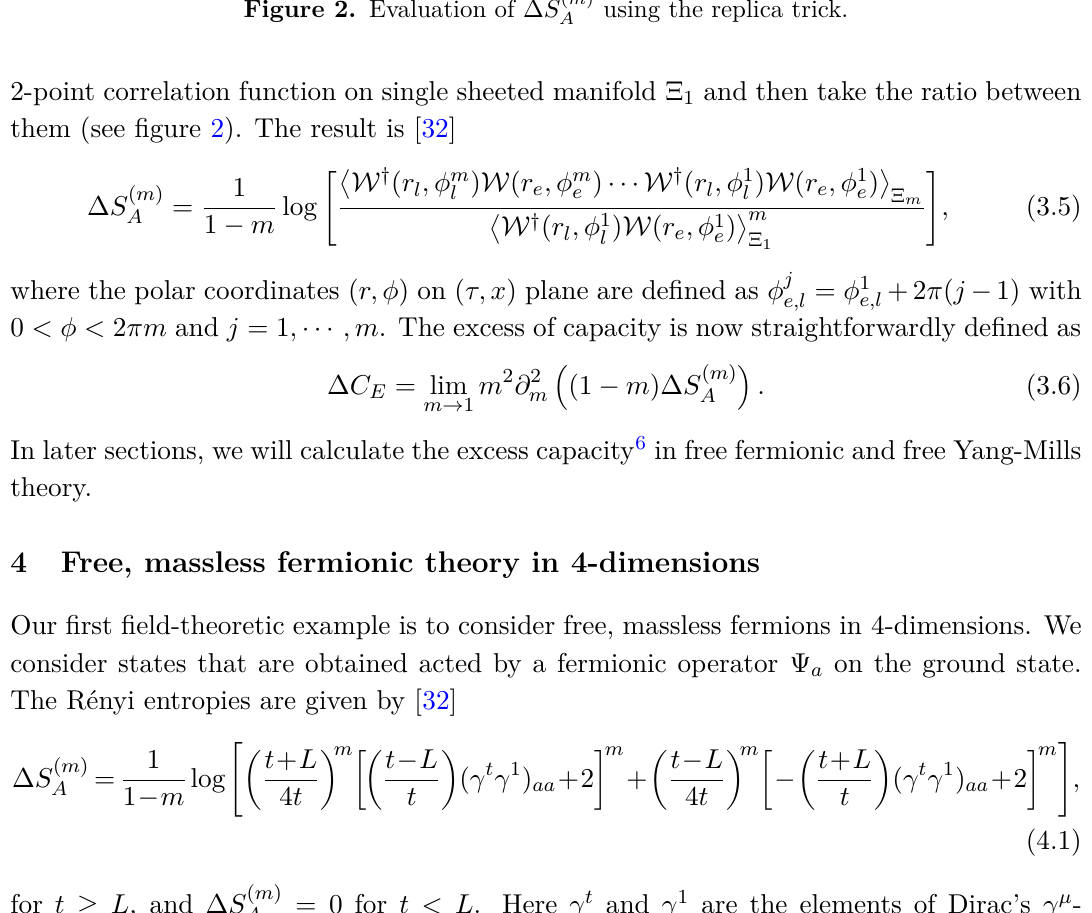
Figure 2. Evaluation of ∆ S ( m )